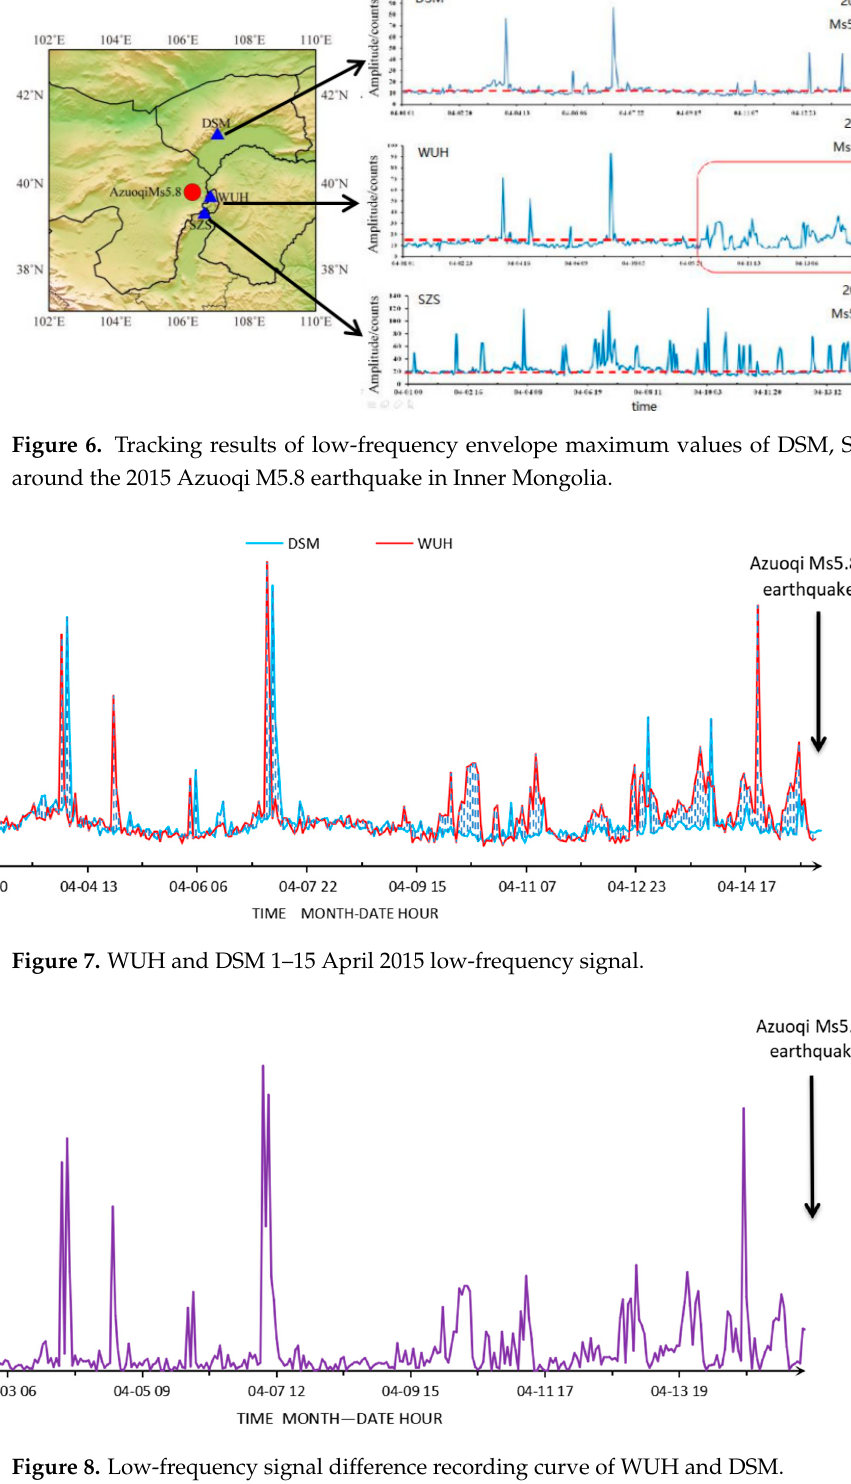
Figure 8. Low-frequency signal difference recording curve of WUH and DSM.